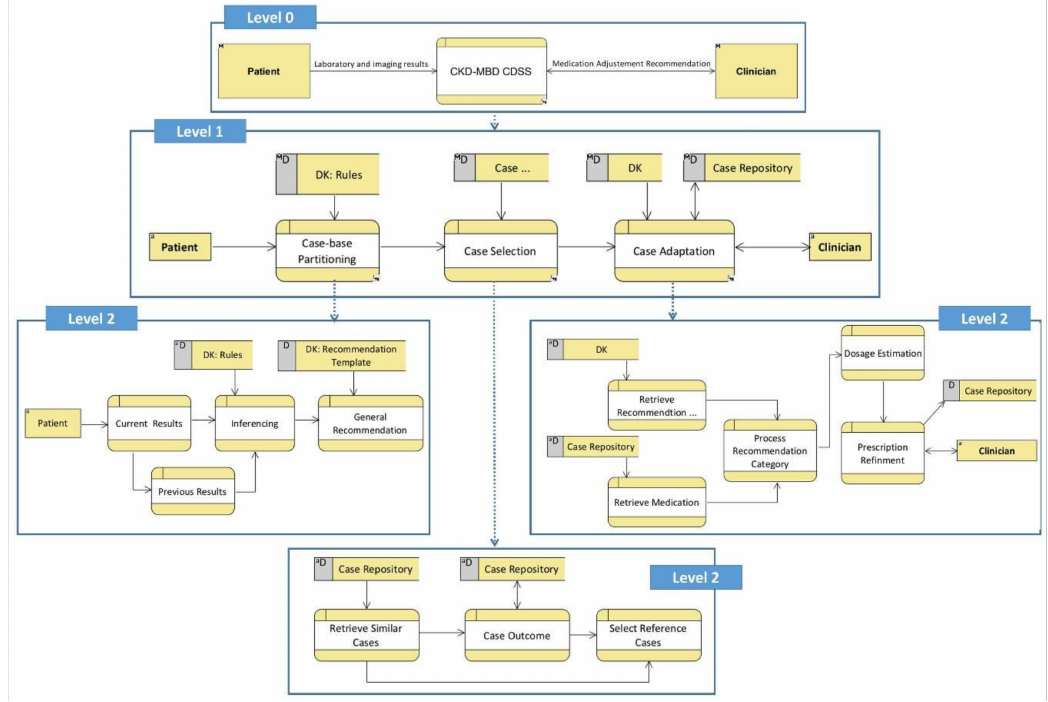
Figure 5. Data flow diagram depicting the relationship between processes and